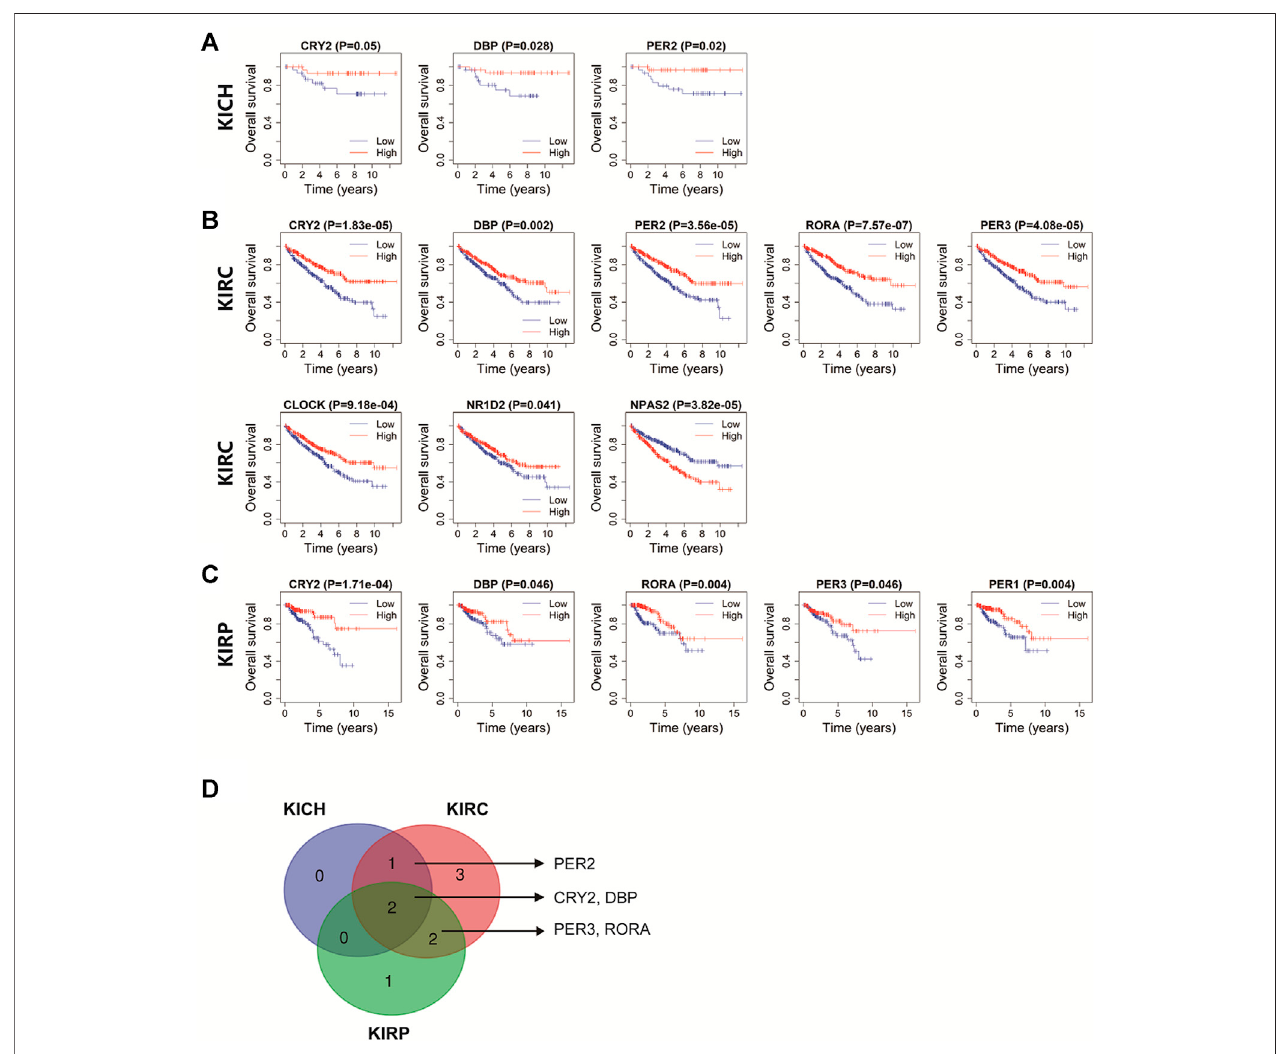
FIGURE 6 | The prognostic value of rhythm genes in pan-RCC. (A – C) The prognostic relevance of core clock genes in pan-RCC. Blue lines represent genes low expressionincancer,redlinesrepresentgeneshighexpressionincancer.Theabscissaofthesurvivalcurveisfortheobservationtime,andtheordinateisforthesurvival rate. Each point on the curve represents the patient survival at that time point. (D) Rhythm genes with signi fi cant prognostic value in at least two database, including PER2, CRY2, DBP, PER3, RORA.